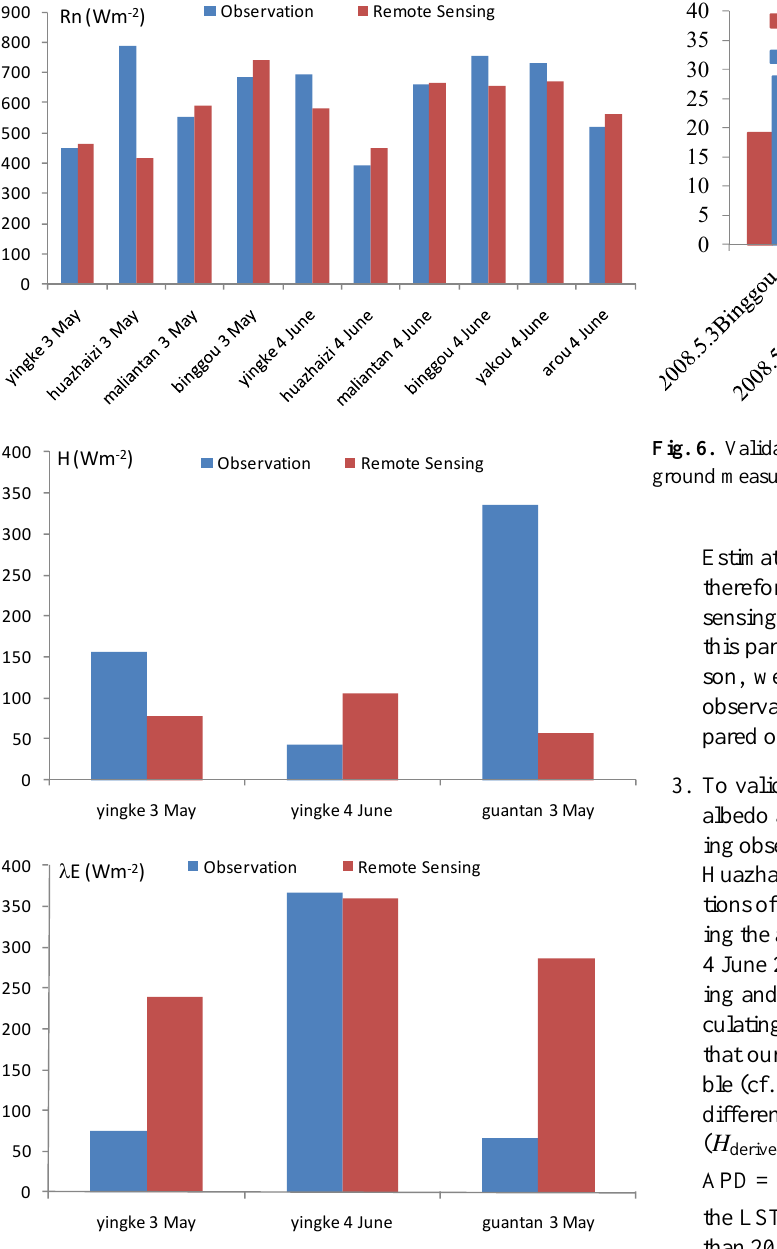
Fig. 7 Validation of the derived albedo against ground measurements over the WATER stations.